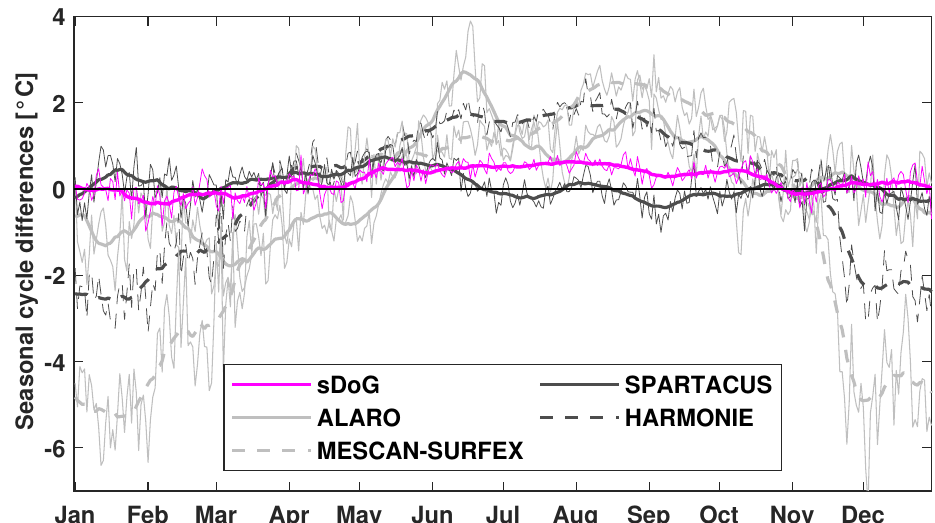
Figure 10. Differences between the mean seasonal cycles of sDoG (magenta), SPARTACUS (dark grey), ALARO (light grey), HARMONIE (dark grey dashed) and UERRA MESCAN-SURFEX (light grey dashed) to VERNAGT air temperature in the true evaluation period (obs-trueval). Shown are the differences of the mean values calculated for each day of year (thin lines), and of moving averages centered on each day of year with a window size of 20 days (solid